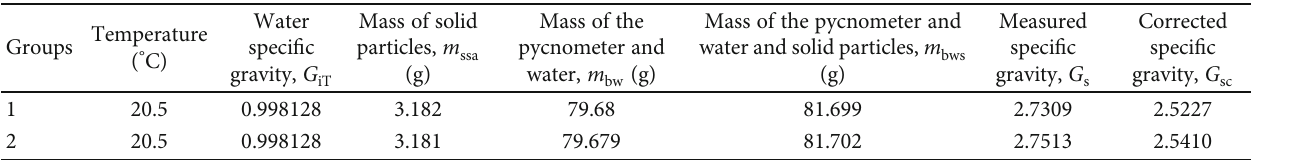
Table 3: Speci fi c gravity before and after